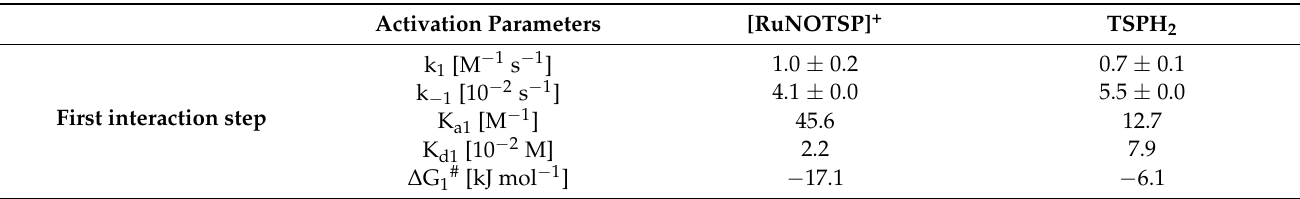
Figure 10. ( a ) Absorption intensity of the formation of ctDNA–[RuNOTSP] + complex as a function of time after mixing of ctDNA with a different concentrations of [RuNOTSP] + ; ( b ) absorption intensity of the formation of ctDNA–TSPH 2 and ctDNA–[RuNOTSP] + complexes as a function of time after mixing for long time. Table 4. Rate constants, affinities, and dissociation constants recorded during the reaction of DNA with [RuNOTSP] + and TSPH 2 at 298 K.